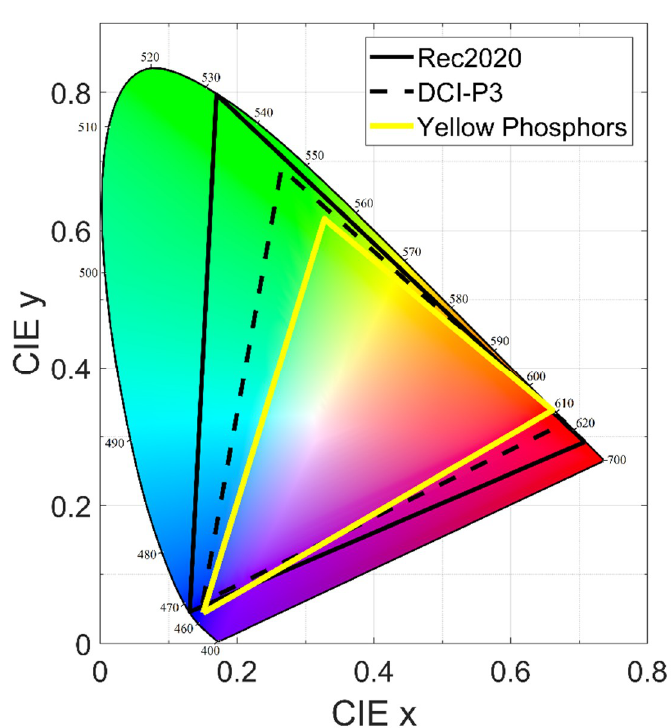
Figure 9. Simulated color gamut for device B with yellow phosphor in CIE 1931 color space.